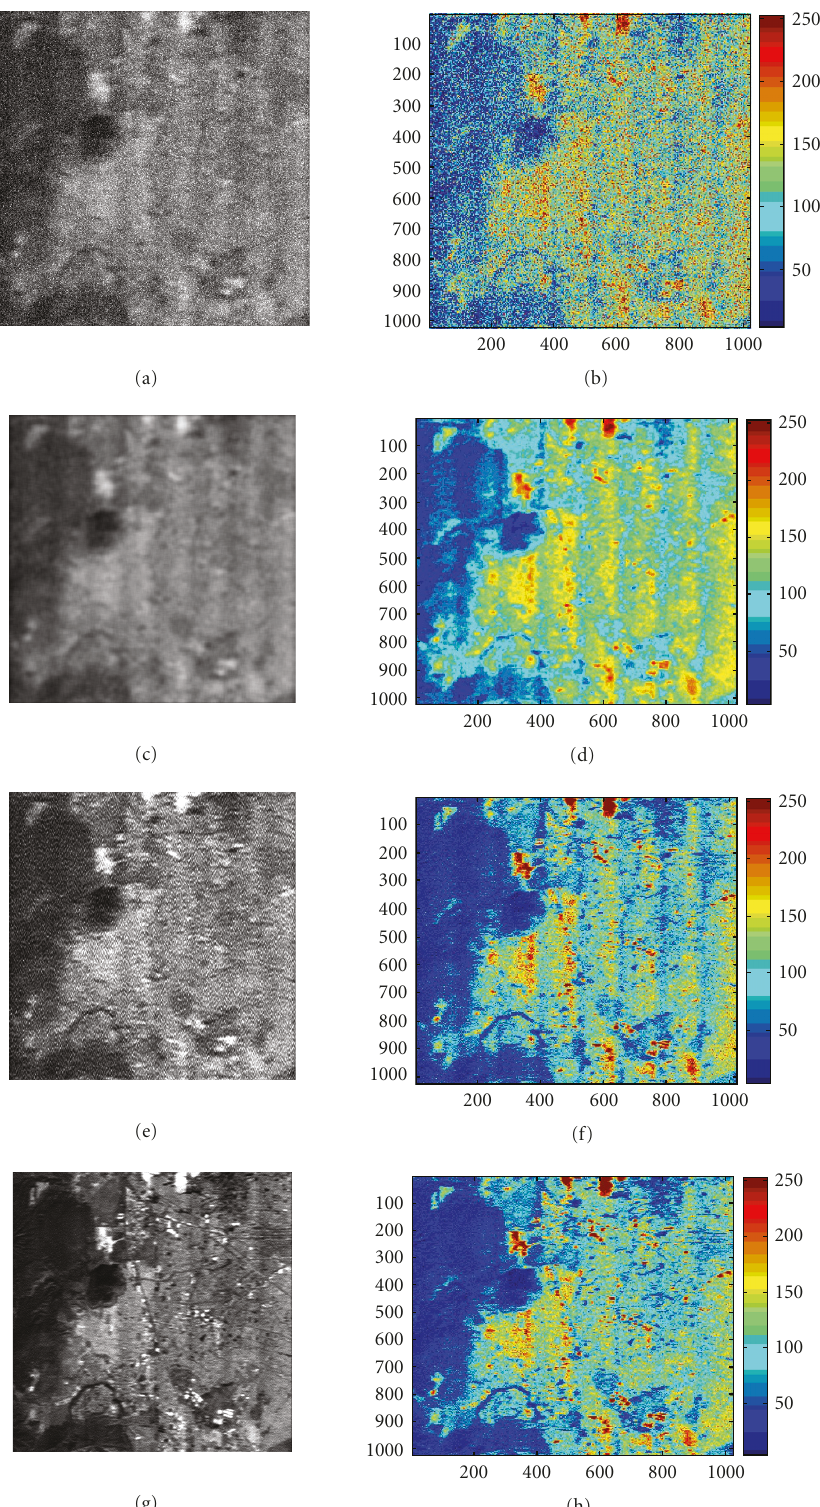
Figure 12: Simulation results for uncertain observation scenario: (SNR μ = 10dB): (a) degraded scene image formed applying the MSF method; (b) the same degraded scene represented in the MATLAB pseudo-color scale; (c) image reconstructed applying the Lee adaptive de-speckling algorithm; (d) the same adaptively de-speckled scene represented in the MATLAB pseudo-color scale; (e) image reconstructed applying the POCS-RSF algorithm; (f) image reconstructed applying the POCS-RSF algorithm represented in the MATLAB pseudo-color scale; (g) image reconstructed applying the POCS-RASF algorithm; (h) image reconstructed applying the POCS-RASF algorithm represented in the MATLAB pseudo-color